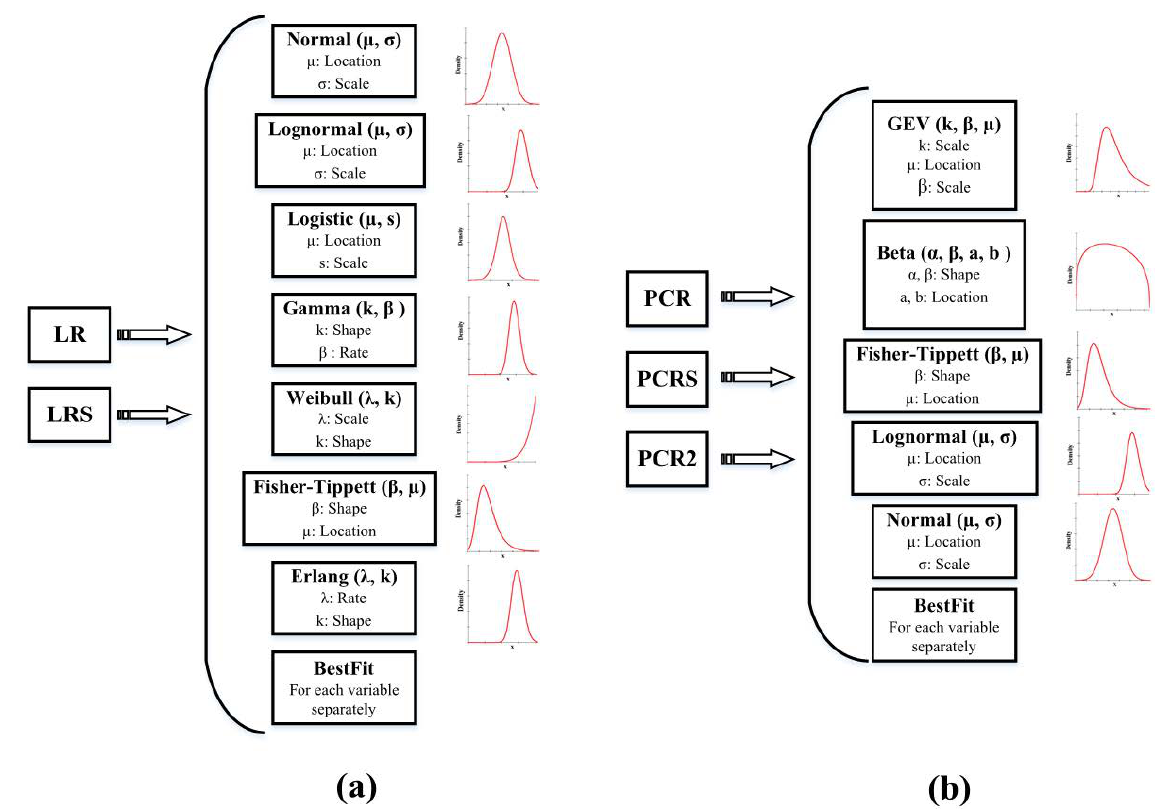
Figure 3. Summary of the average annual weather variables distributions selected for use in LR and LRS regression models ( a ) and their associated principal components distributions selected for use in PCR, PCRS and PCR2 regression models ( b ) of the impact assessment